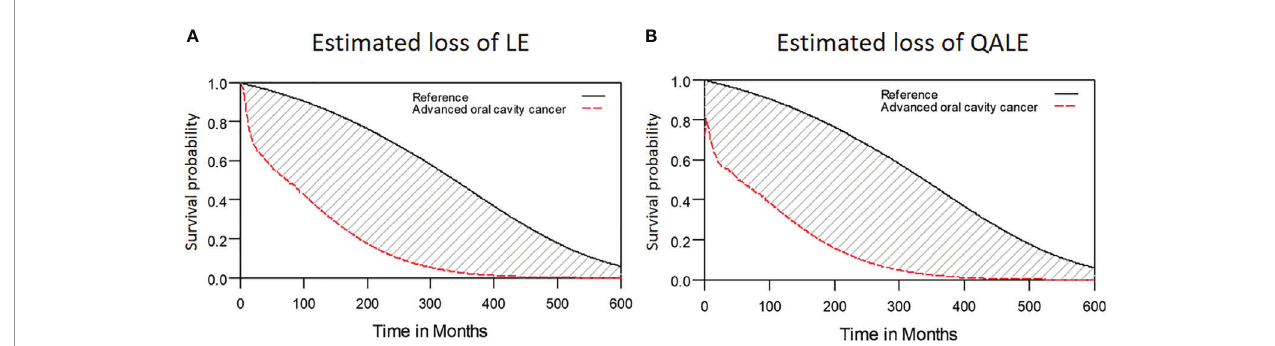
FIGURE 3 | Estimated loss of LE and QALE for advanced OSCC patients. (A) Estimated loss of LE; (B) Estimated loss of QALE.